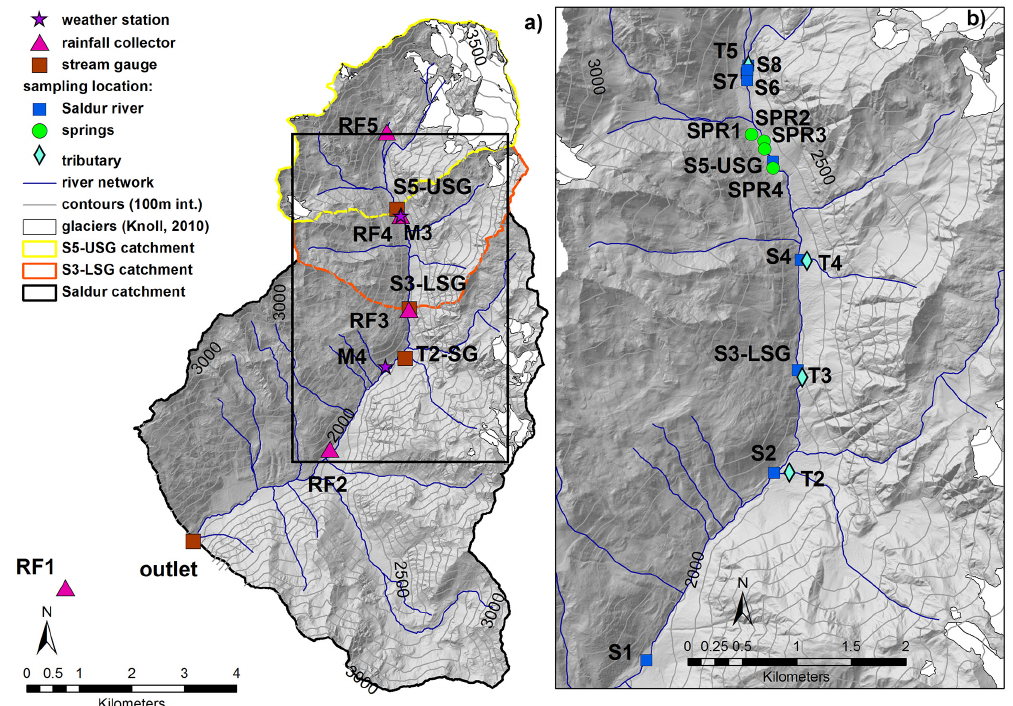
Figure 1. Map of the Saldur catchment with position of the rainfall collectors, stream gauges and weather stations (a) ; close-up showing the sampling locations for isotopic and EC analysis (b)